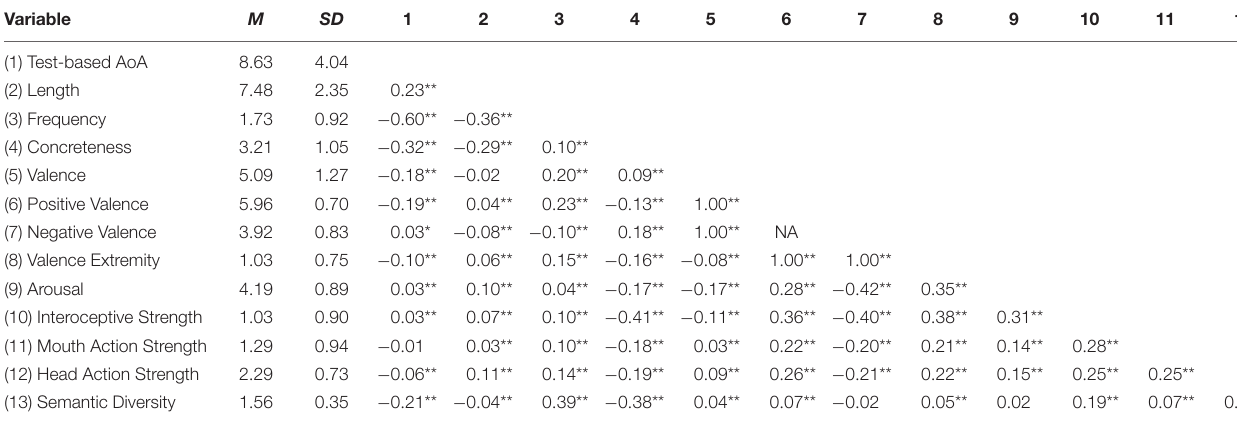
TABLE 1 | Means, standard deviations, and correlations of all variables of interest. Variable